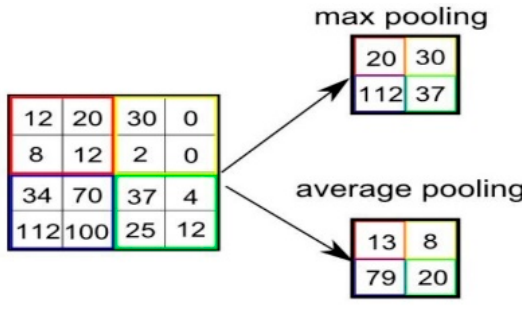
Figure 4. Max pooling in CNN.